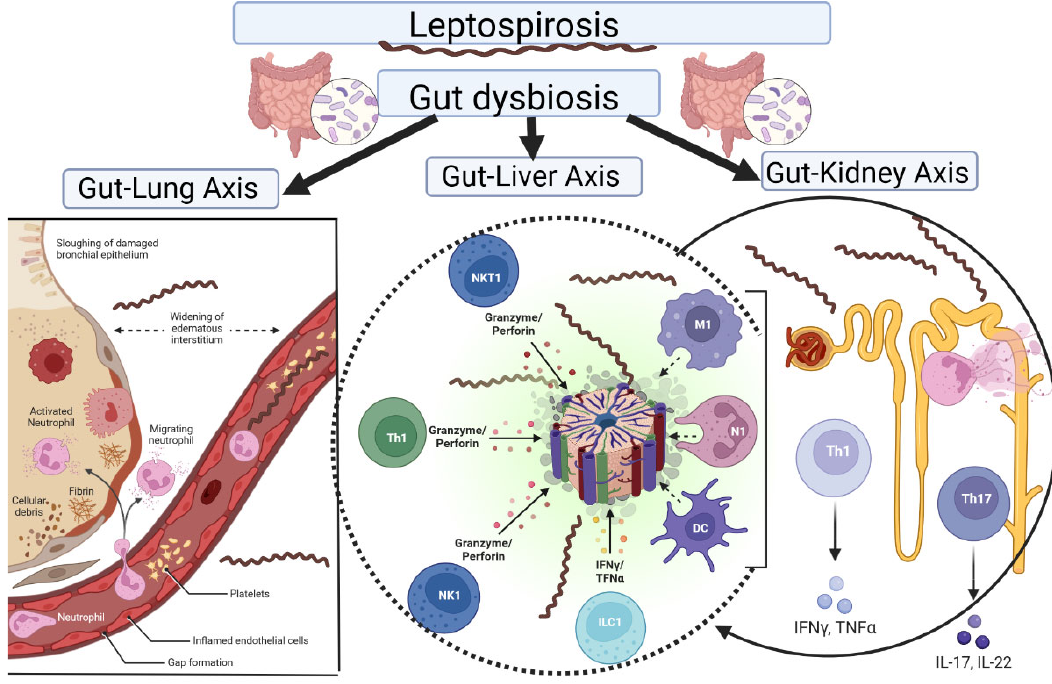
Figure 5. The influence of altered gut microbiota on the course of leptospirosis. According to our hypothesis, leptospirosis-induced gut dysbiosis can lead to a pro-inflammatory immune response, which can be one of the factors that lead to a severe course of leptospirosis.